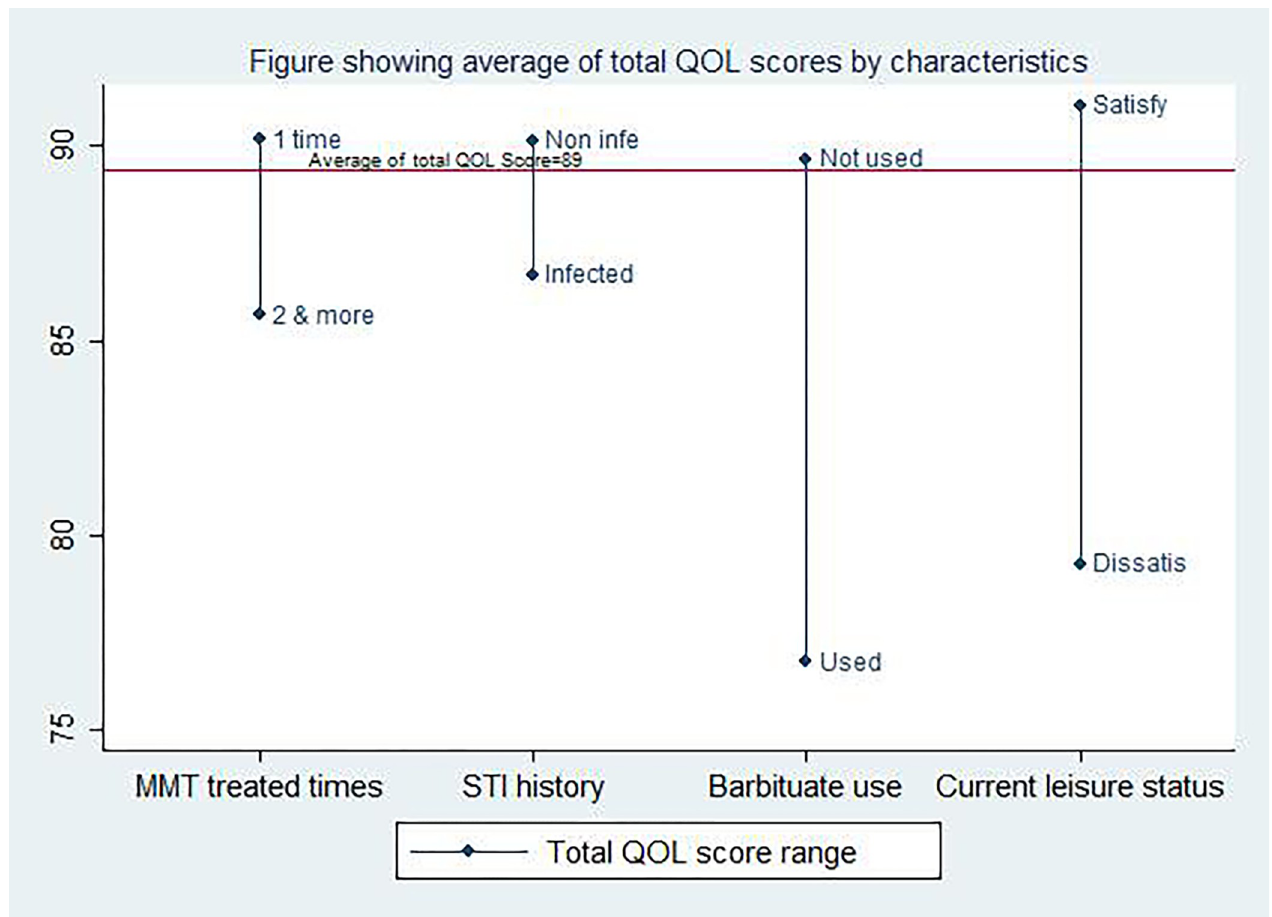
Fig 1. Graph showing average of total quality of life (QOL) score differences by characteristics. Y-axis shows the average of the total QOL score. X-axis shows significant characteristics associated with average of the total QOL